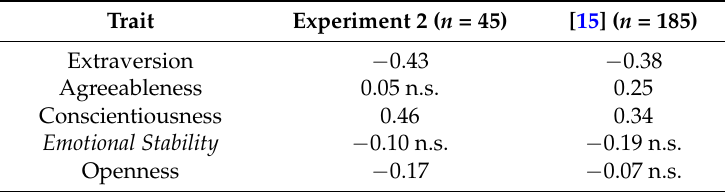
Table 7. Prediction of noise sensitivity from Big Five traits for participants in Experiment 2. Note that Shephard used the neuroticism construct, which is considered the inverse of emotional stability . Trait Experiment 2 ( n =